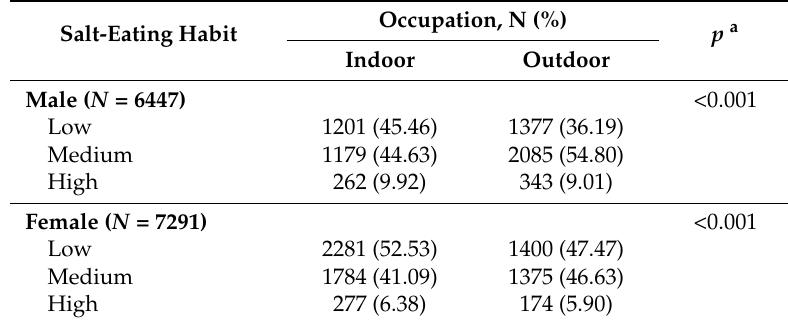
Table 2. Percentage distributions of participant for self-reported salt-eating habit in each occupational category stratified by